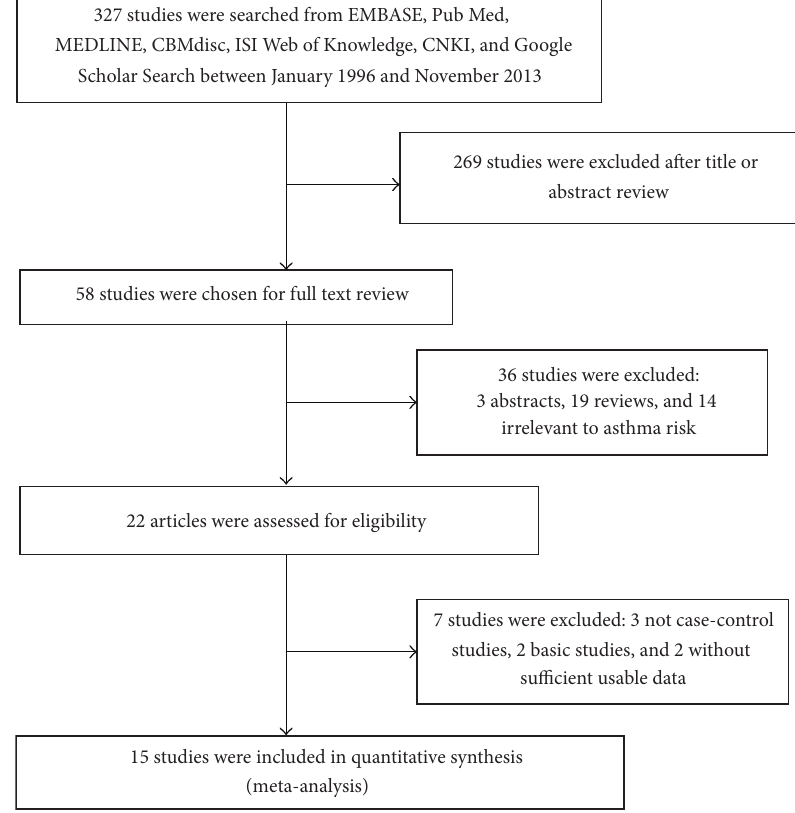
Figure 1: Flow of studies identification, inclusion, and